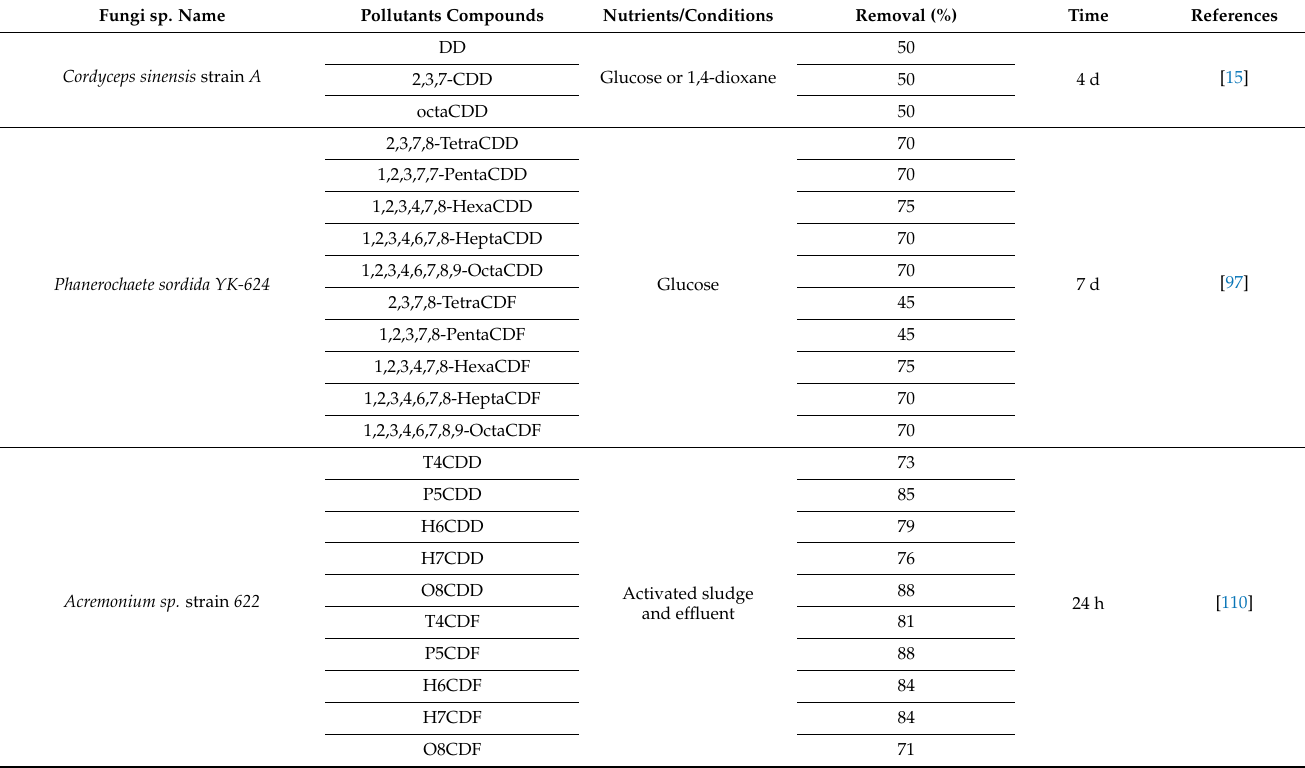
Table 5. Degradation of dioxins by fungi strains in soil